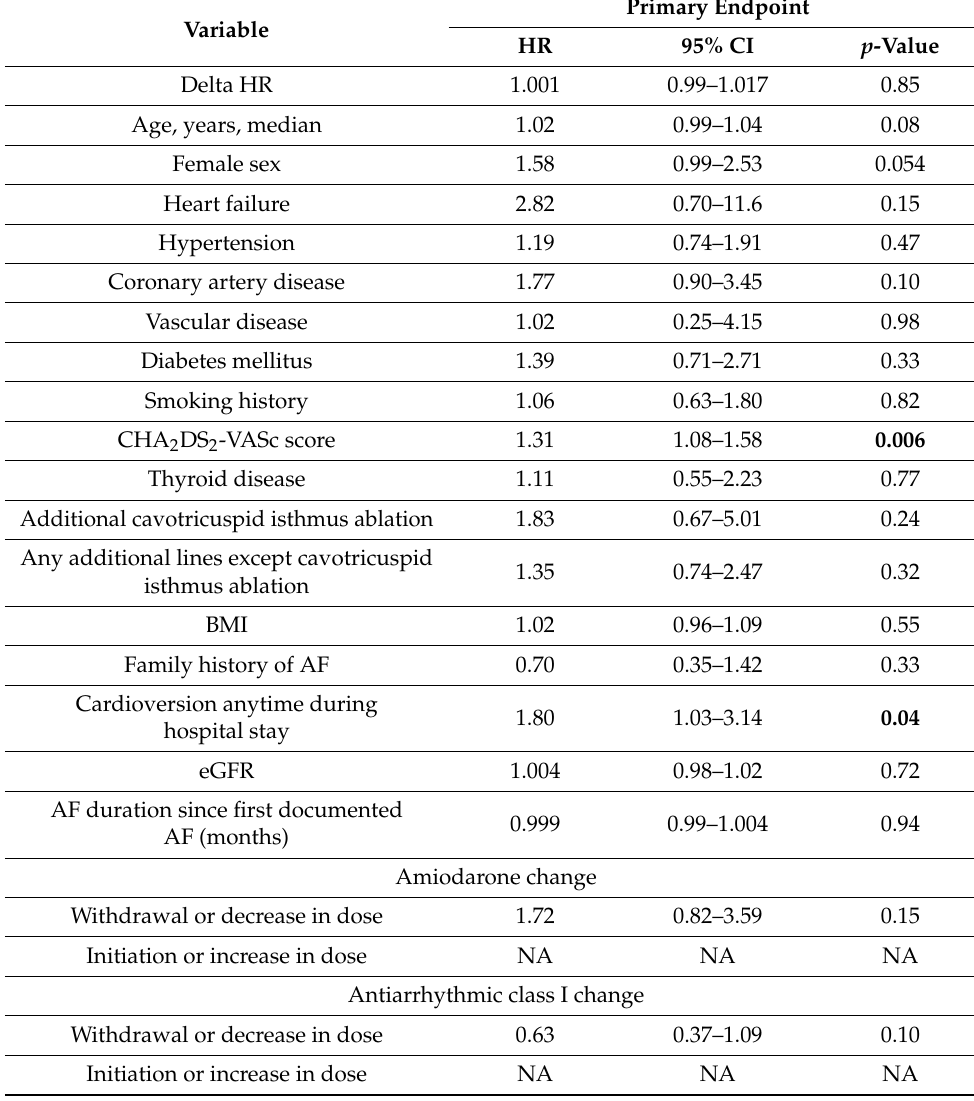
Table 4. Univariable analyses of predictors of AF